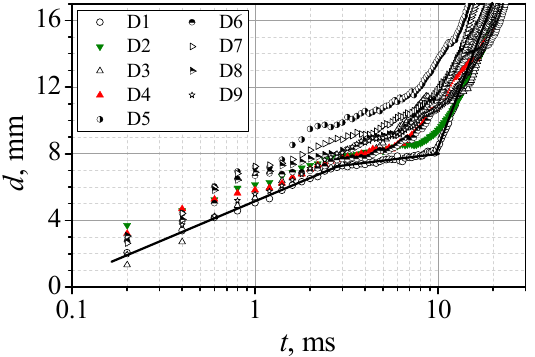
Figure 4. Summary of data obtained for free-falling drop experiments listed in Table 2. Solid lines show the approximation found for Case D1 (see Figure 2).